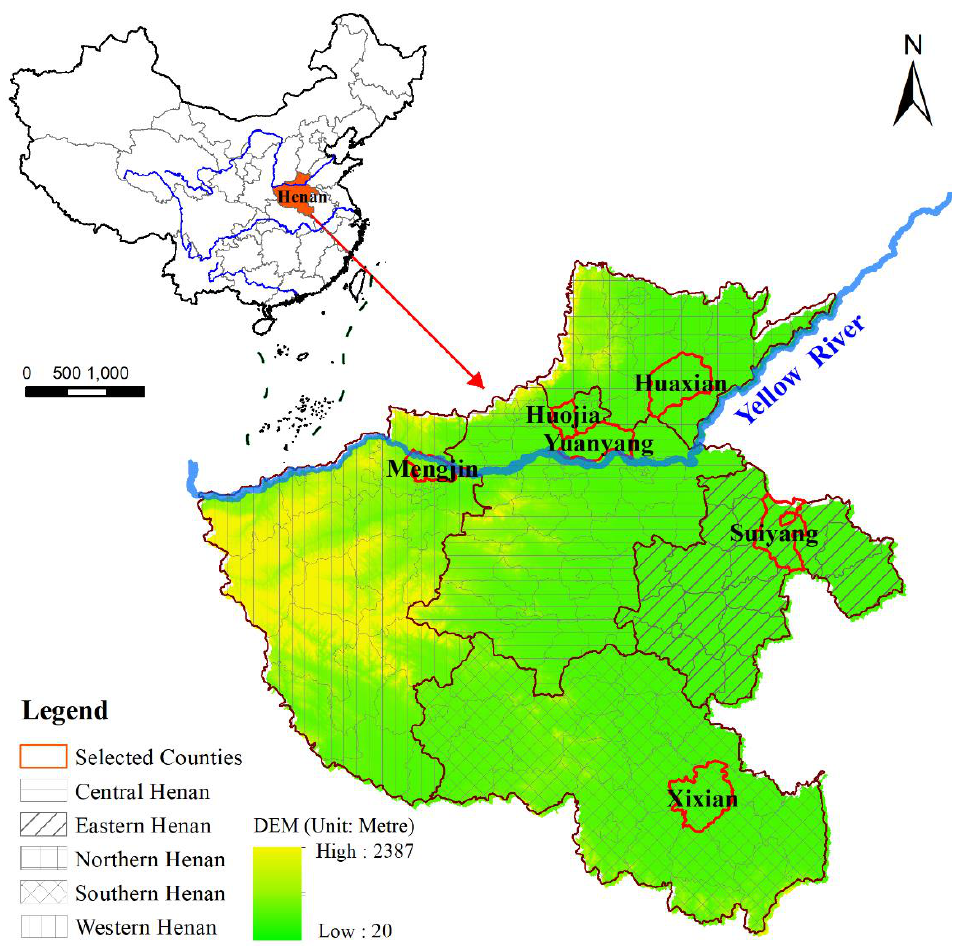
Figure 2. Location and terrain of Henan Province (The administrative division vector data were downloaded from the Global Administrative Division Database (http://gadm.org/) (accessed on May 12, 2022)).